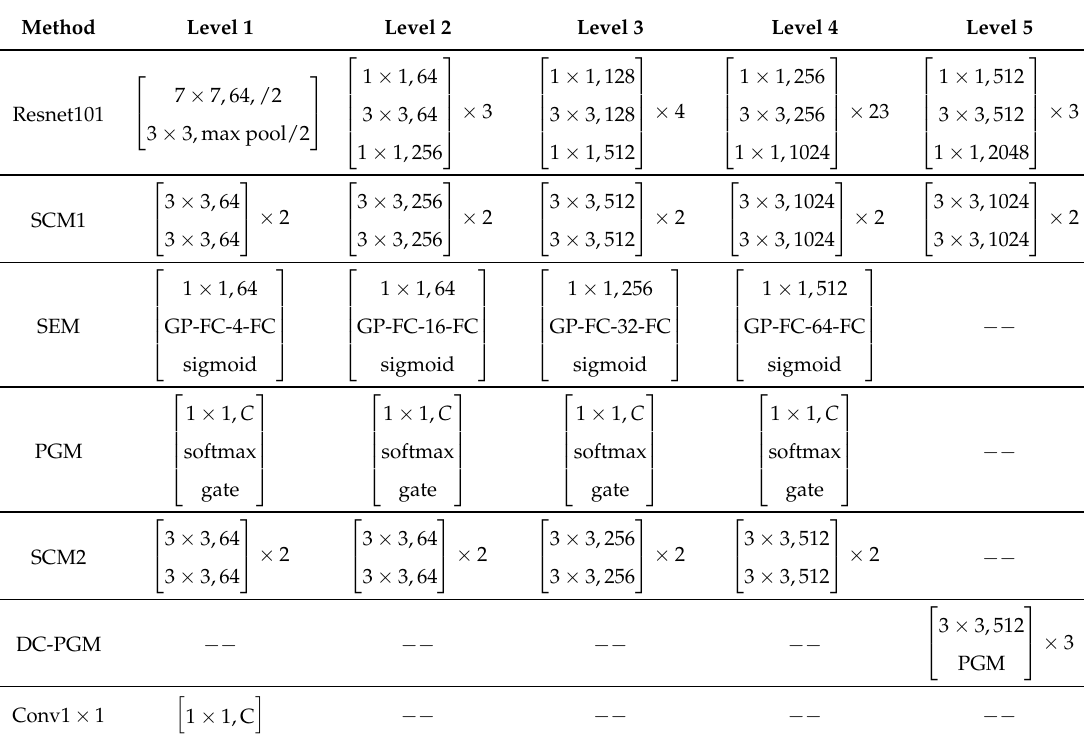
Table 1. L-GCNN configuration. Here, C stands for number of objects to be segmented, “/2” indicates that strides for convolution are equal to 2 and “ × ” outside the bracket indicates that the convolution group in the bracket is repeated by the following